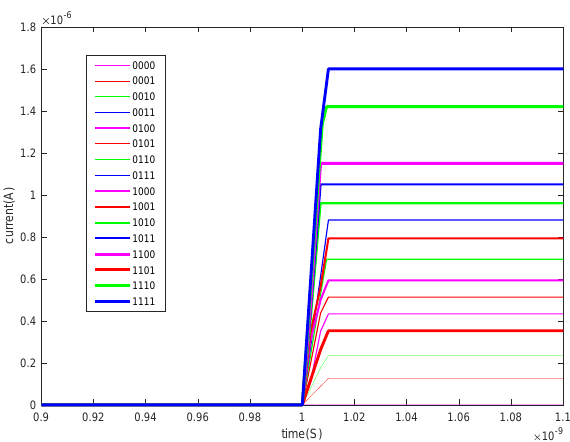
Figure 18. The current of the read operation.